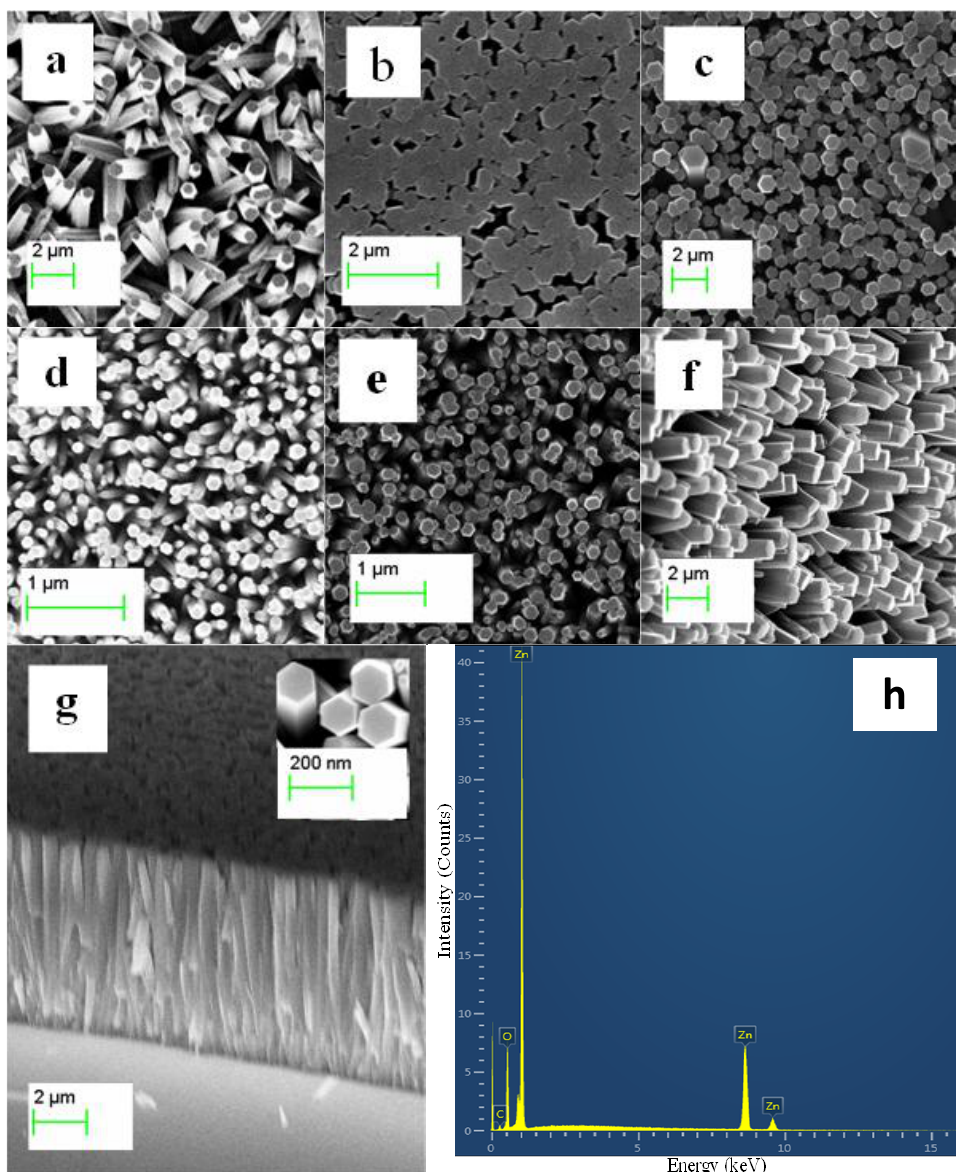
Figure 2. The FESEM image of the ZnO nanorods grown using a seed solution of chitosan with different amounts of ZnO nanoparticles. ( a ) 0; ( b ) 10; ( c ) 30; ( d ) 50; ( e ) 70; ( f ) 90; ( g ) the cross-sectional image of the ZnO nanorods grown using the seed solution (90 mg of ZnO nanoparticle); and ( h ) The EDX spectrum of the ZnO nanorods grown by using the seed solution of ZnO nanoparticles containing 70 mg of ZnO nanoparticles in the chitosan solution.